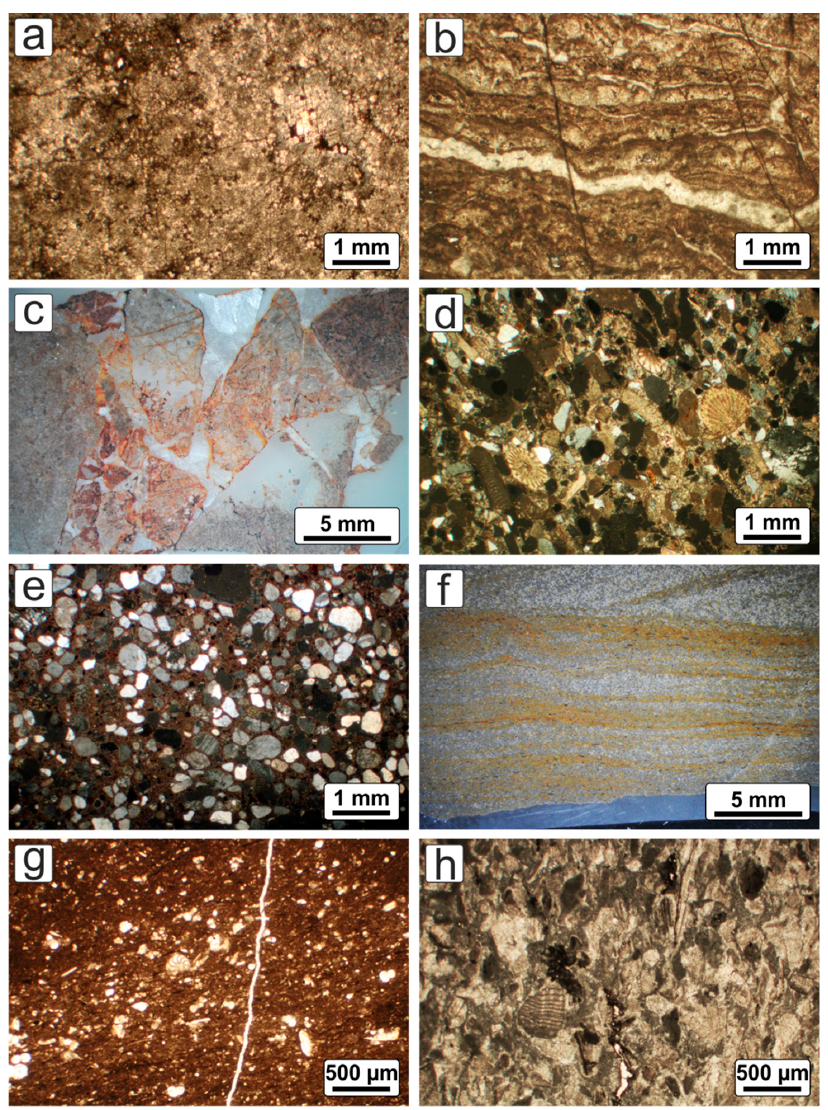
Figure 10. Photomicrographs of the recognized lithologies: ( a ) massive metadolostone lacking defined sedimentary fabrics (sample TAR5, 1.25x, CPL = Cross Polarized Light); ( b ) laminated metadolostone (bindstone) showing well preserved algal mats (TAR32, 1.25x, CPL); ( c ) brecciated metadolostone with angular clasts and fractures filled by calcite (TAR7, 0.63x, SMRL = Stereoscopic Microscope Reflected Light); ( d ) hybrid arenite sensu Zuffa [80] (sandy allochem limestone sensu Mount, [82]) made up by quartz, feldspars and abundant fossils in a carbonate cement (TAP27, 1.25x, CPL); ( e ) “sandstones” s.l. consisting of rounded submillimeter-sized quartz and feldspar grains floating in a reddish carbonate binder (TAP37, 1.25x, CPL); ( f ) siltite showing a well preserved wavy cross-stratification (TASC7, 0.63x, SMRL); ( g ) marly limestone with planktonic fauna (TAR19, 2.5x, PPL = Plane Polarized Light); ( h ) bioclastic limestone (packstone) of possible Mesozoic age exhibiting a rich fossiliferous content (TAR19, 2.5x,